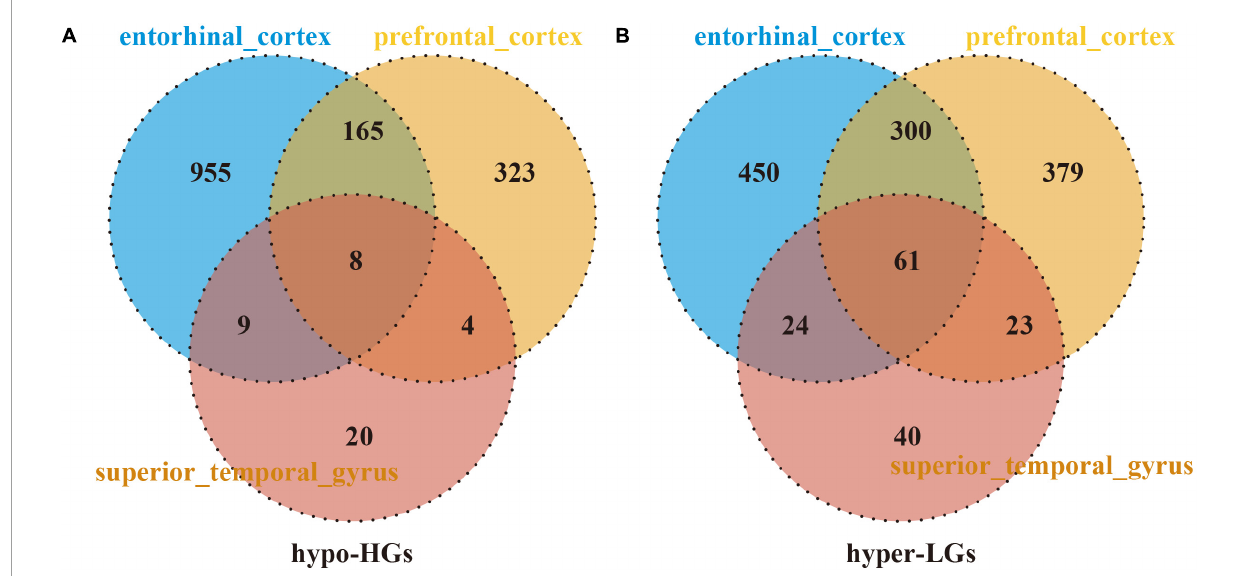
FIGURE3 Identification of Alzheimer’s disease (AD)-related cerebral-cortex-shared differentially expressed genes (DMGs). The Venn diagram reveals eight hypomethylated-mediated highly expressed genes (hypo-HGs) (A) and 61 hypermethylated-mediated lowly expressed genes (hyper-LGs) (B) .